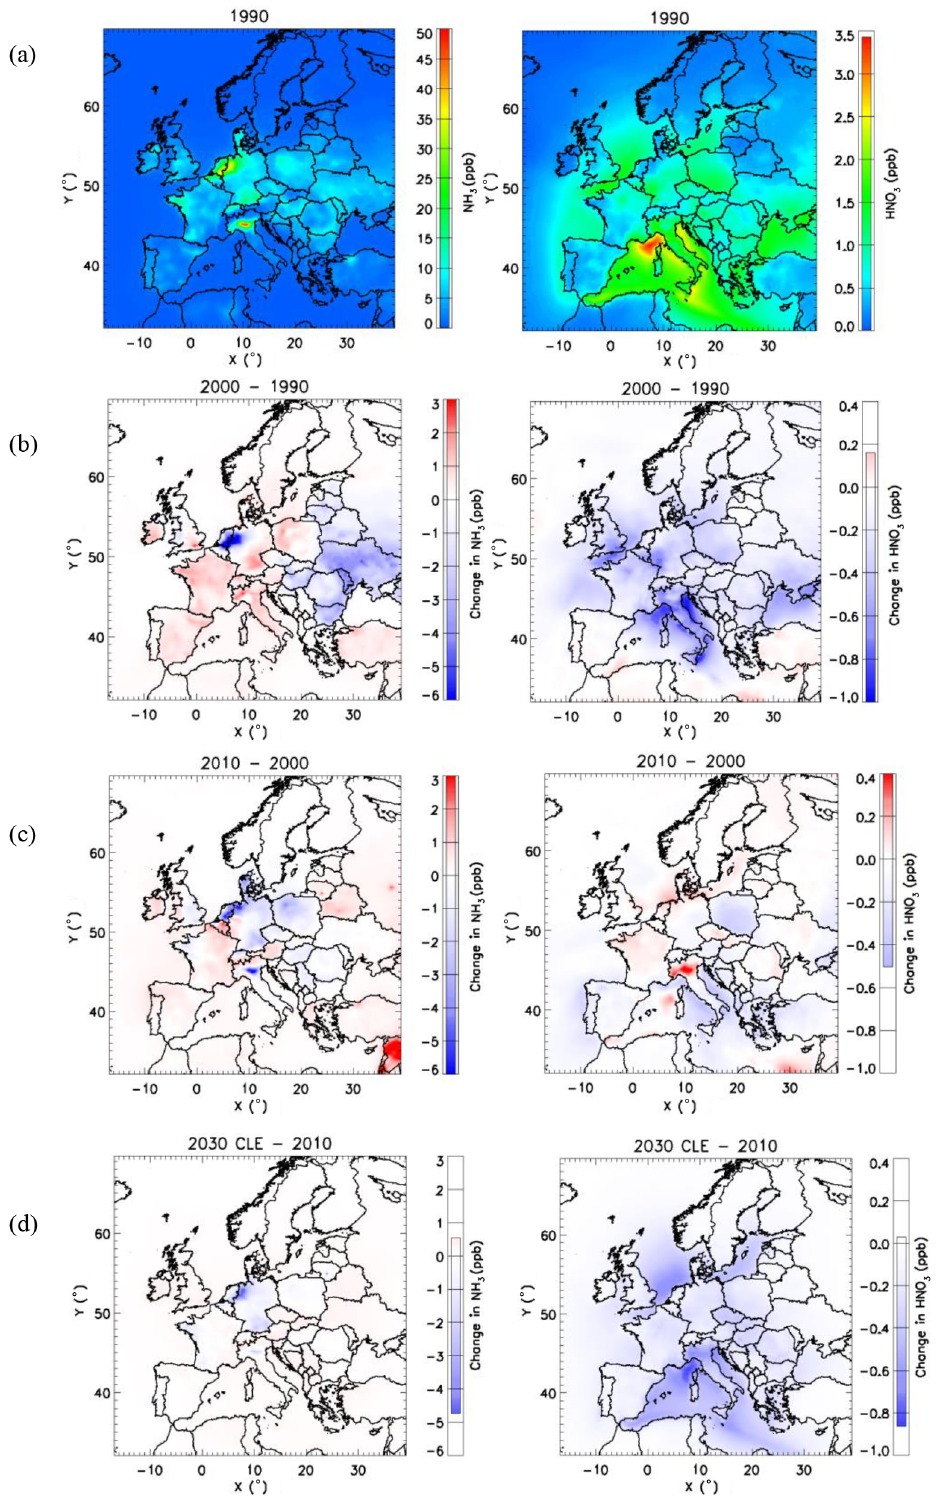
Figure 2. Ammonia (left) and nitric acid (right): (a) annual average concentrations (ppb) in 1990; changes (ppb) between (b) 1990–2000, (c) 2000–2010 and (d)